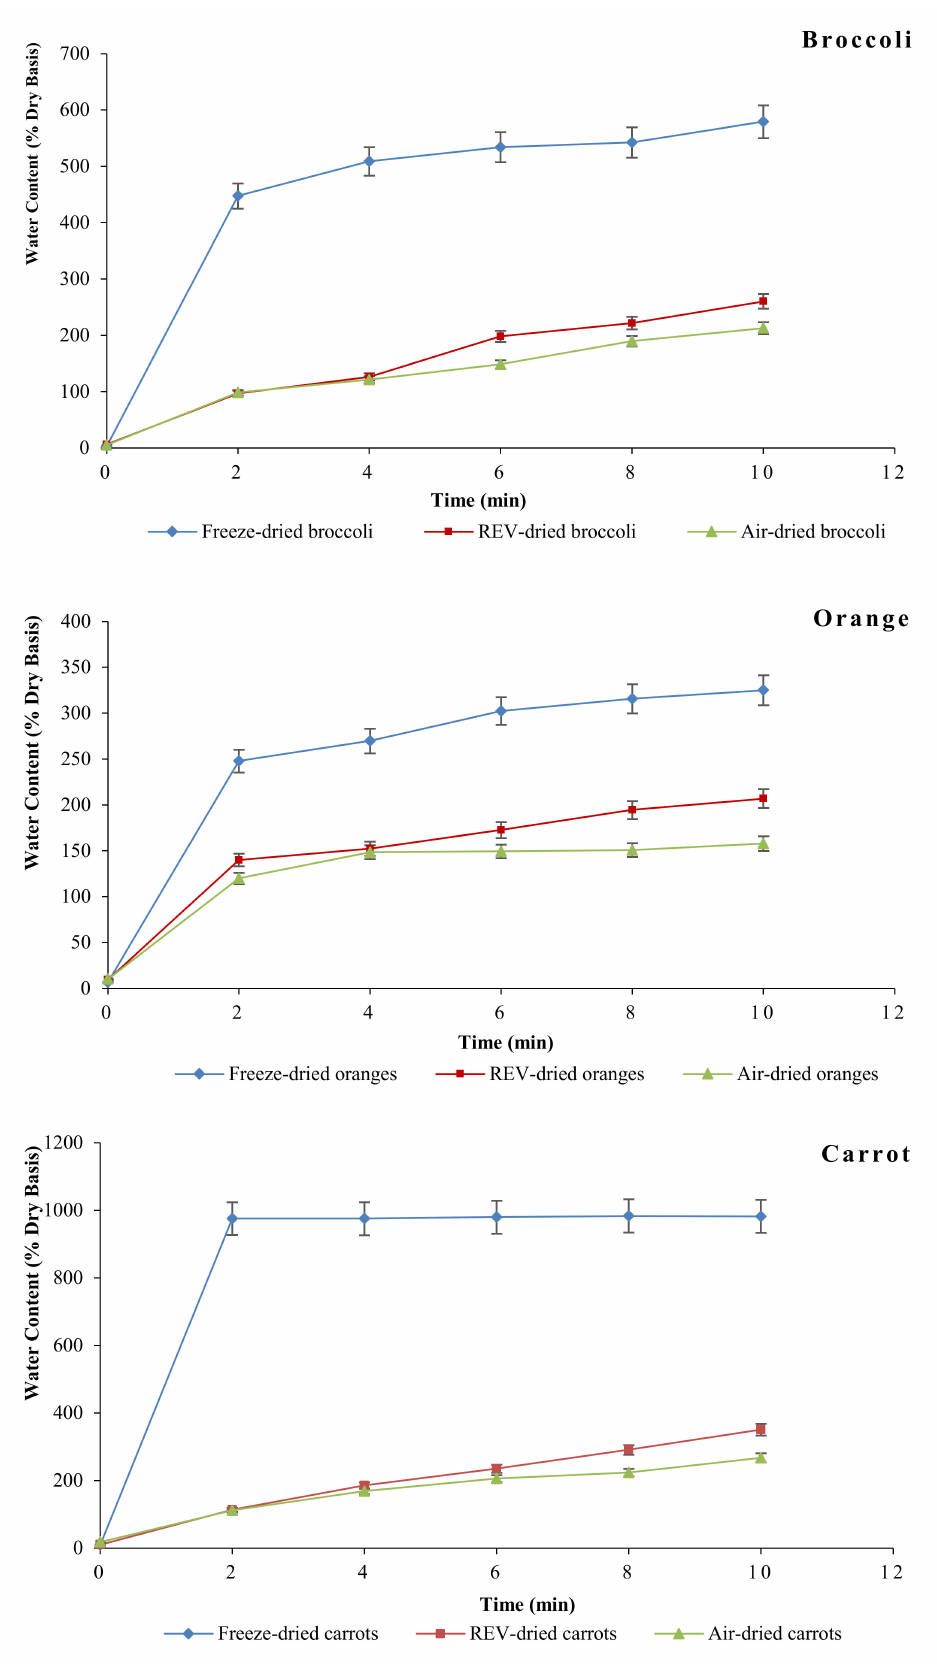
Figure 3. Rehydration curves of REV-dried, freeze-dried, and air-dried products at 30